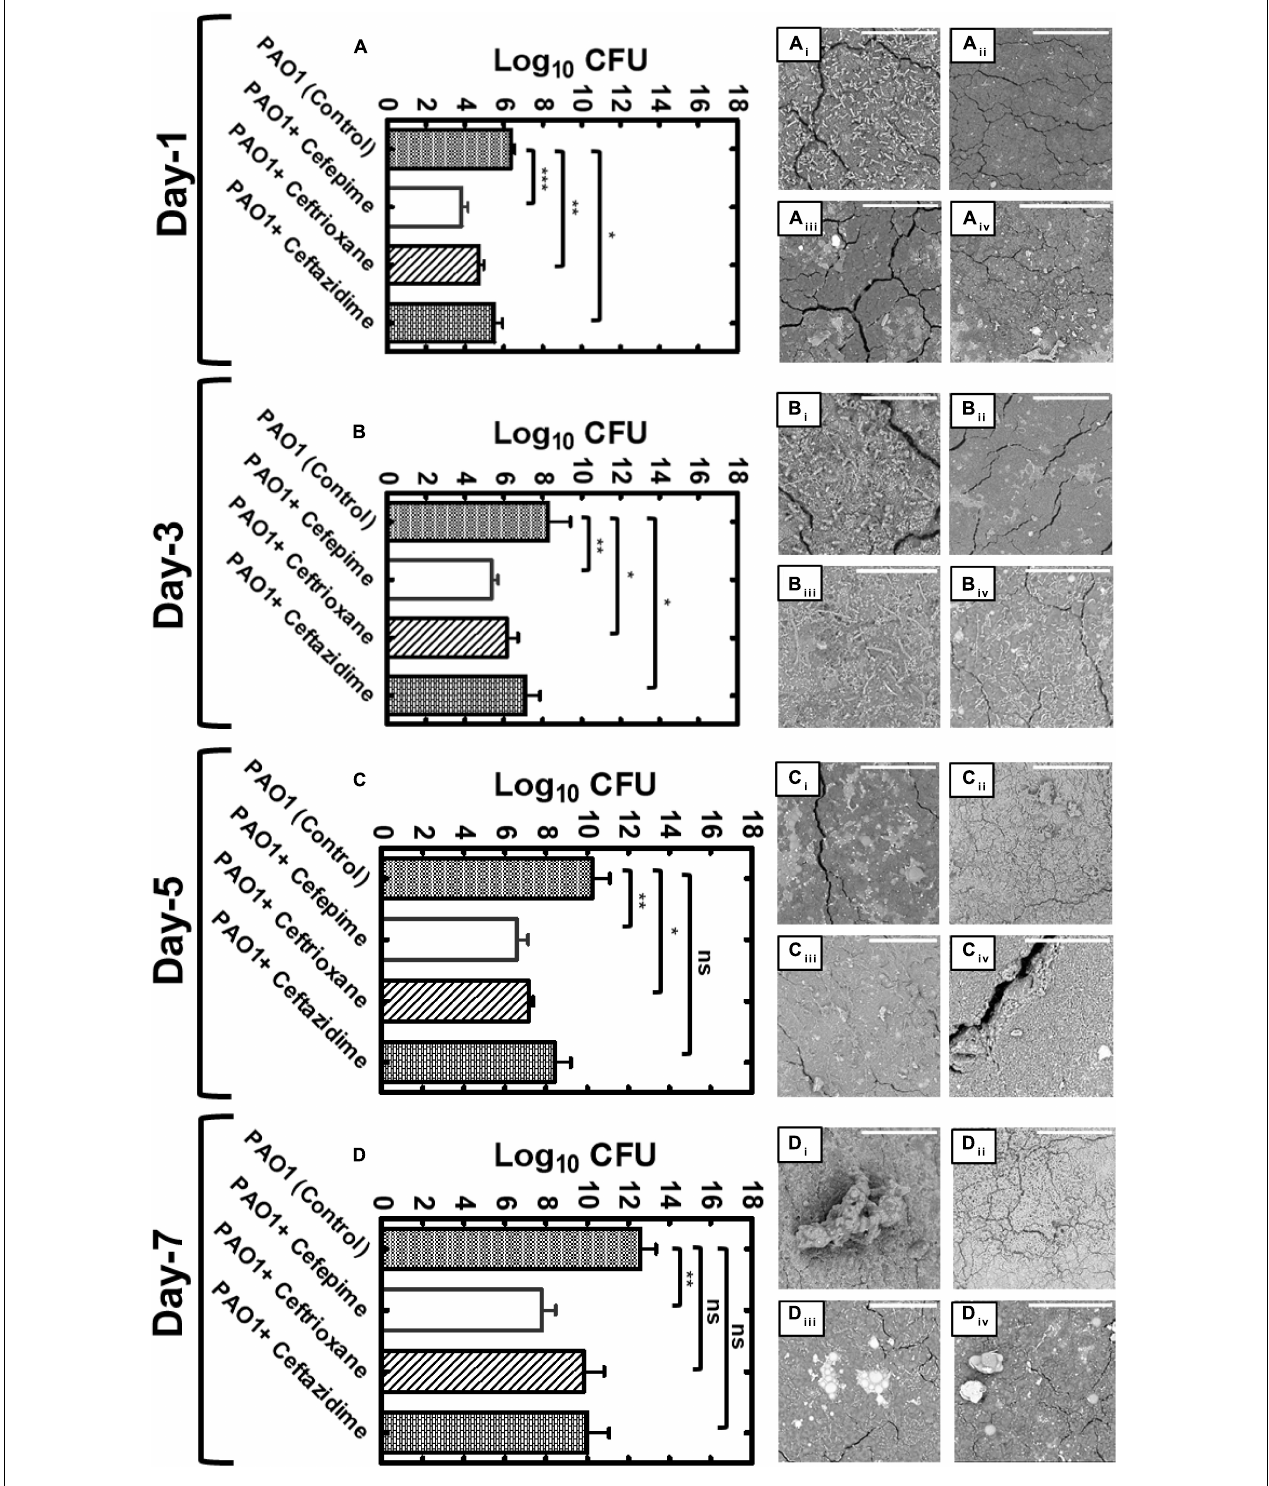
FIGURE 5 | Effects of QS inhibition by cephalosporins on biofilm formation by PAO1. Graphical representation of live bacterial cell quantification of Pseudomonas aeruginosa PAO1 on urinary catheter surface under sub-MIC concentrations of CP, CT and CF for day-1 (A) , day-3 (B) , day-5 (C) and day-7 (D) (ns p > 0.05, * p ≤ 0.05, ** p ≤ 0.01, *** p ≤ 0.001). Scanning Electron Microscope (SEM) images of biofilms formed by P. aeruginosa PAO1 on the urinary catheter in the presence of CP, CF, CT on day-1 (A ii ,B ii ,C ii ,D ii ) , day-2 (A ii ,B ii ,C ii ,D ii ) , day-3 (A iii ,B iii ,C iii ,D iii ) and day-4 (A iv ,B iv ,C iv ,D iv ) (Scale bars represent 50 µ m).